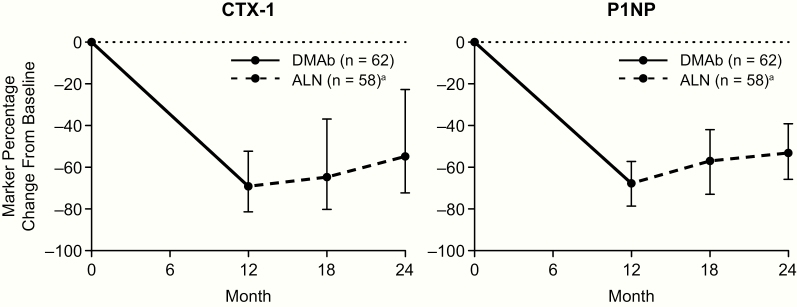
BTM percentage change from baseline with denosumab in year 1 and alendronate in year 2. Data show mean and interquartile range. n = number of participants with measurements at baseline and month 12 (DMAb) or month 24 (ALN). Abbreviations: ALN, alendronate; BTM, bone turnover marker; CTX-1, serum C-telopeptide; DMAb, denosumab; P1NP, N-terminal propeptide type I procollagen. aAt month 18, n = 60.